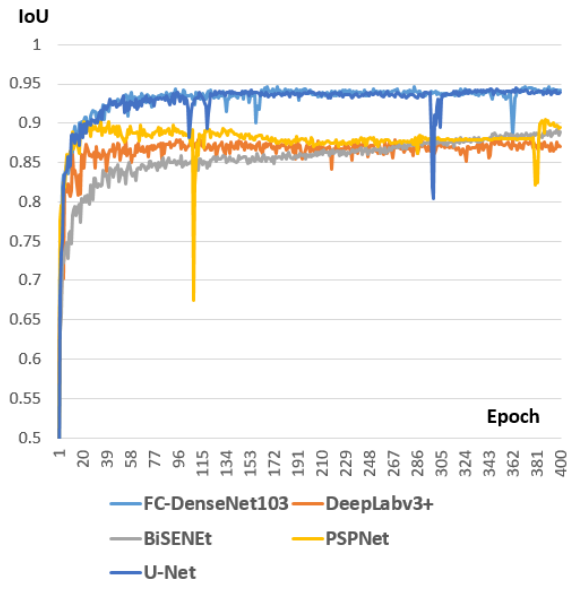
Figure 12. IoU after every epoch of the